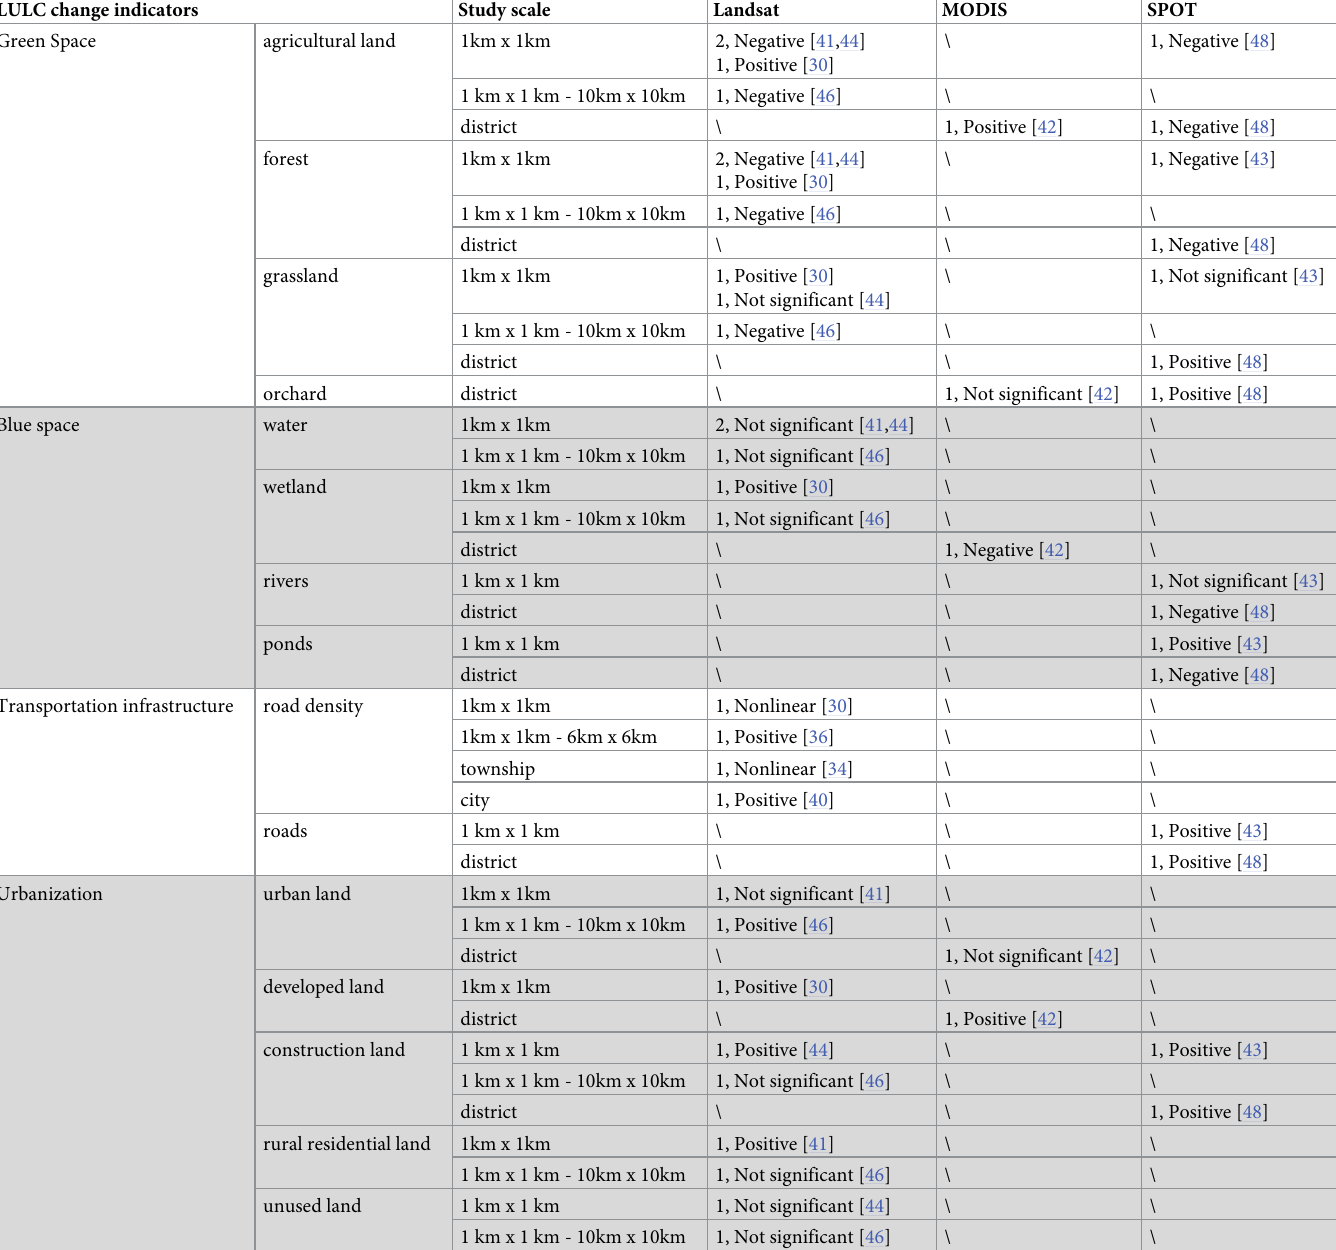
Table 3. The effects of LULC change indicators with different RS data source or different study scale (number of related studies, effects). LULC change